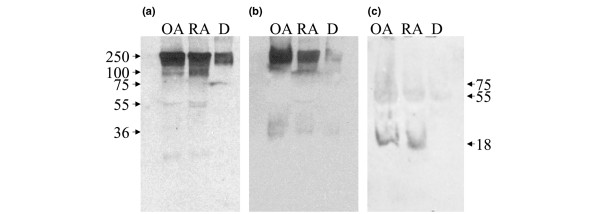
Western blots of synovial fluid samples from rheumatoid arthritis and osteoarthritis patients and organ donors. Representative western blots of synovial fluid samples from asymptomatic donors (D) and osteoarthritis (OA) and rheumatoid arthritis (RA) patients. (a) Nonreduced conditions with anti-pro-osteogenic protein 1 (OP-1) antibody (R2854). (b) Nonreduced conditions with anti-mature OP-1 antibody (MAB354). (c) Reduced gel with anti-mature OP-1 antibody (MAB354). Samples were diluted 1:100. The numbers on gels represent the size of the protein bands of interest. The same amount of protein was loaded onto each lane.